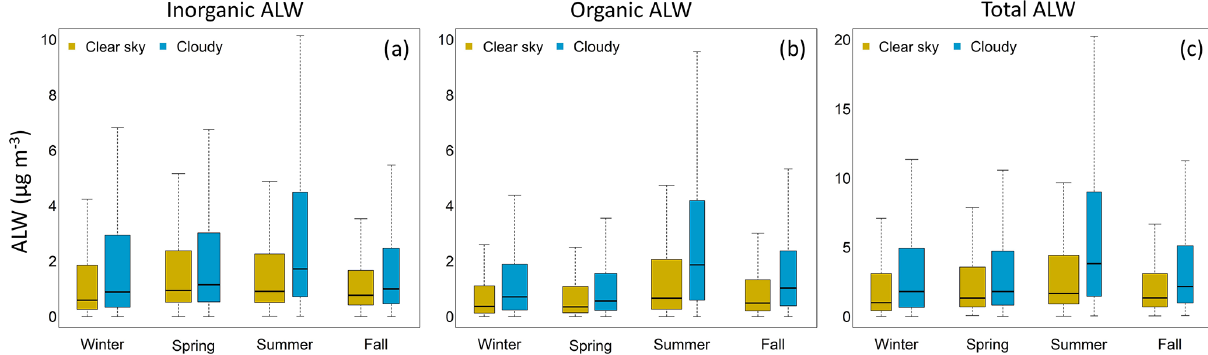
Figure 4. Distributions of (a) inorganic ALW, (b) organic ALW, and (c) total (inorganic + organic) ALW during clear-sky (yellow) and cloudy (blue) times in all seasons across the CONUS. The width of the box plot is proportional to the number of observations that make up each distribution. Note that potential outliers are not shown but are used in